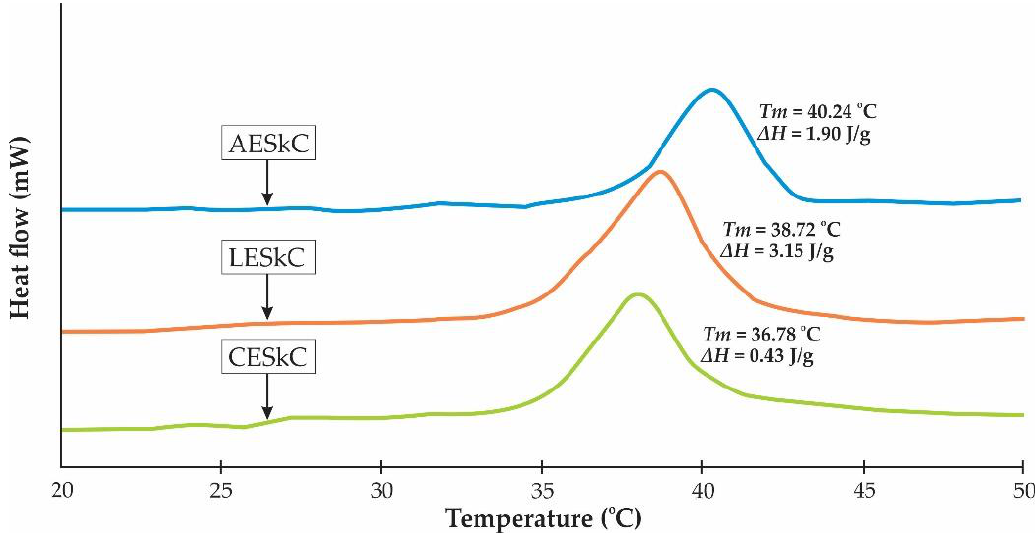
Figure 5. DSC thermogram of lizardfish skin collagens extracted with different acids. AESkC: acetic acid-extracted collagen; LESkC: lactic acid-extracted collagen; CESkC: citric acid-extracted collagen.